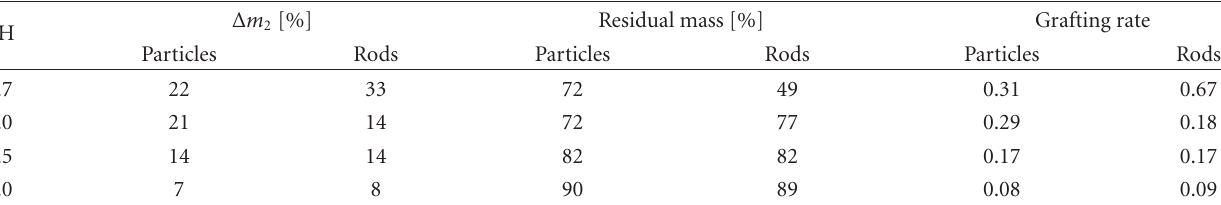
Scheme 2: Surface modification of Gd 2 O 3 :Er 3+ ,Yb 3+ with PEG- b -PAAc at low ( ∼ 3.7) and increased ( ≥ 5) pH and the formation of a gadolinium-PEG-b-PAAc-complex . Table 1: Mass loss ( Δ m 2 ) and grafting rate ( Δ m 2 /residual mass) determined by TG-DTA for PEG- b -PAAc modified ParticlesHP-CTAB and Rods5 as a function of the modification